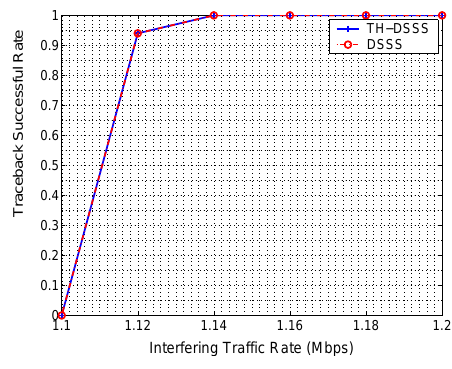
Figure 17: ROC Showing Accuracy of Time Hopping-based Spread Spectrum Techniques for Forensic